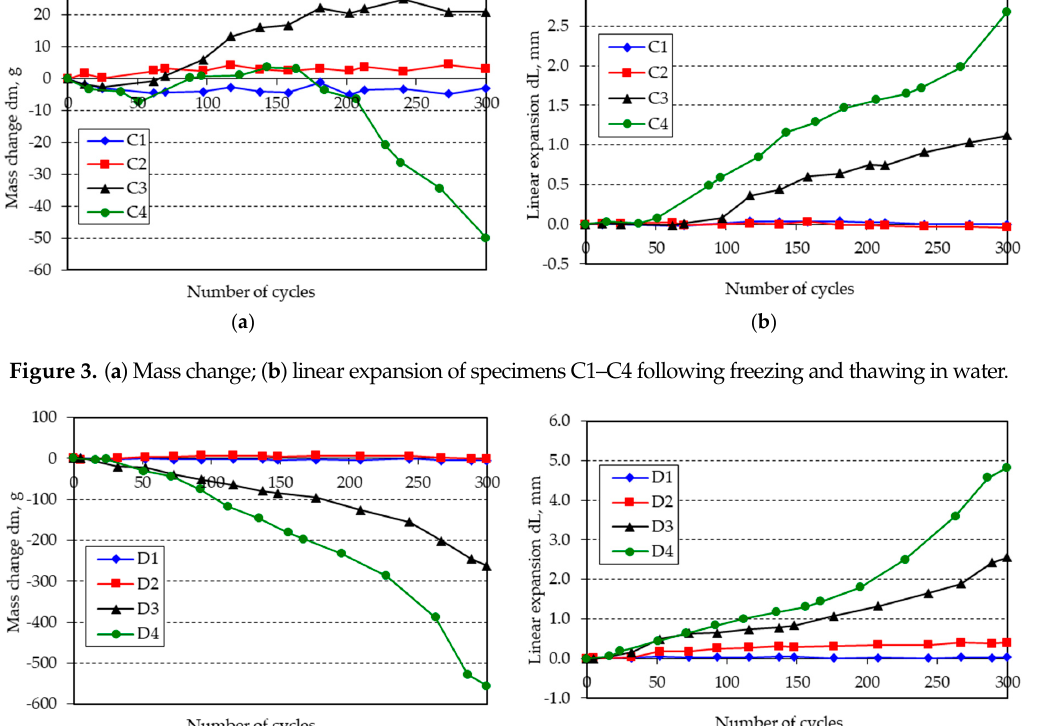
Figure 2. ( a ) Mass change; ( b ) linear expansion of specimens B1–B4 following freezing and thawing in water.